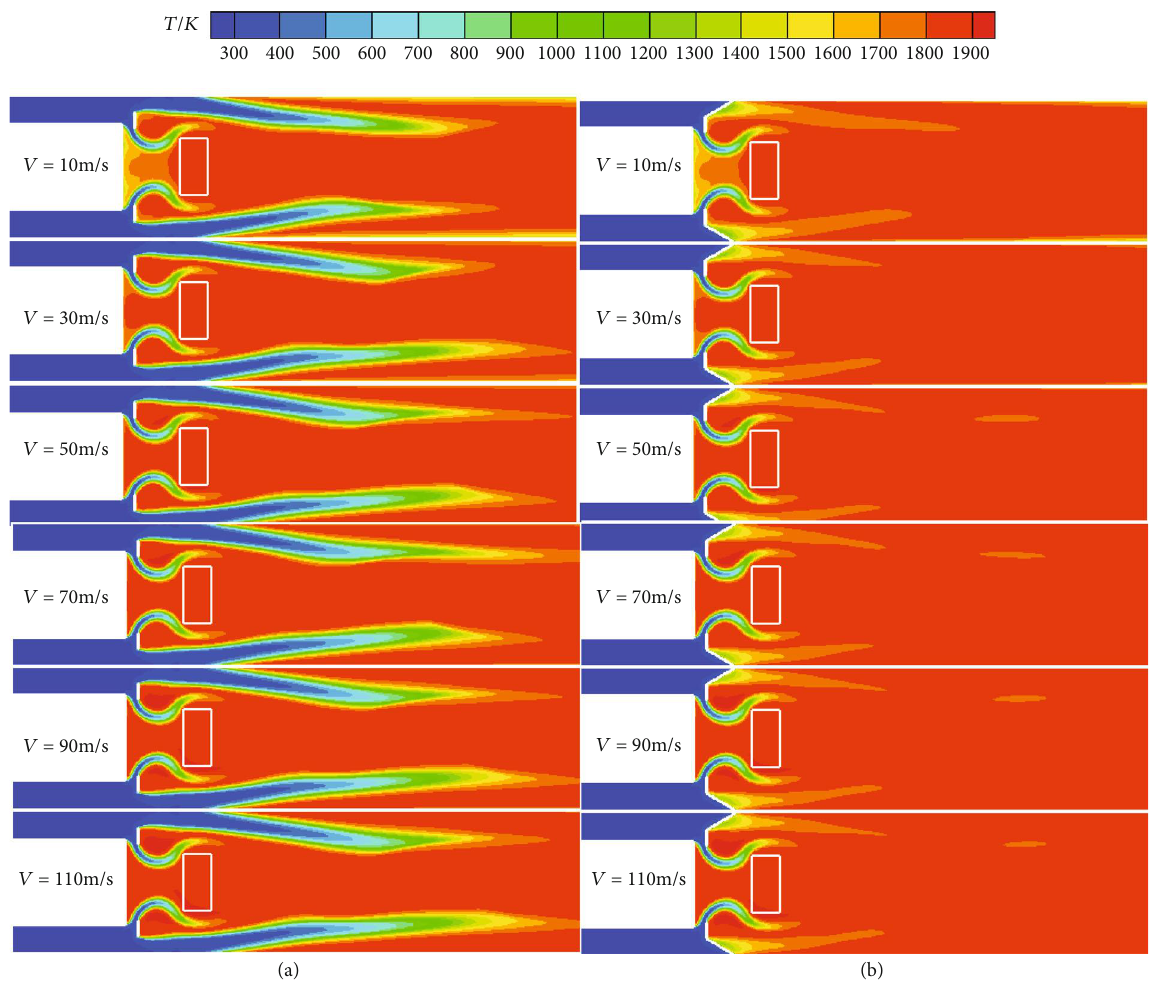
Figure 24: Temperature fi eld under di ff erent inlet